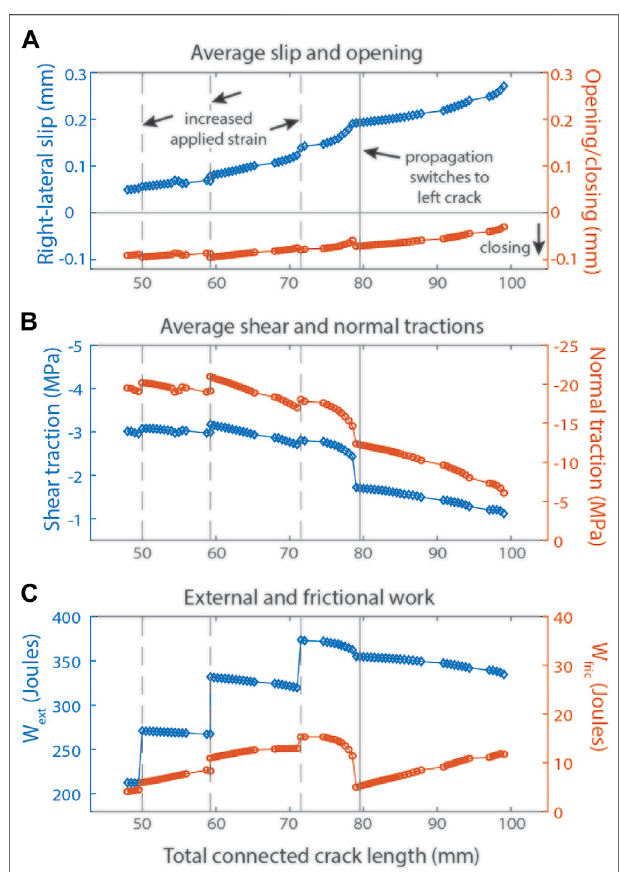
FIGURE 11 | (A) Average slip and opening (negative values re fl ect closing) on the pre-cut cracks in the heterogeneous model ( fi nal fracture geometry shown in Figure 9E ) at each increment of fracture growth, plotted against the total connected fracture length. Horizontal discontinuities re fl ect fracture growth steps that incorporated pre-existing microcracks, resulting in a bigger increase in the total connected fracture length than the addition of individual elements. Dashed grey lines mark where fracture growth stopped and the applied strain was increased. Solid grey lines indicate when fracturegrowthswitchedfromtheuppercracktothelowercrackinthemodel. (B) Average shear and normal stress on the pre-cut cracks. (C) External work and frictional work, plotted for each increment of fracture growth, against the total connected fracture length.